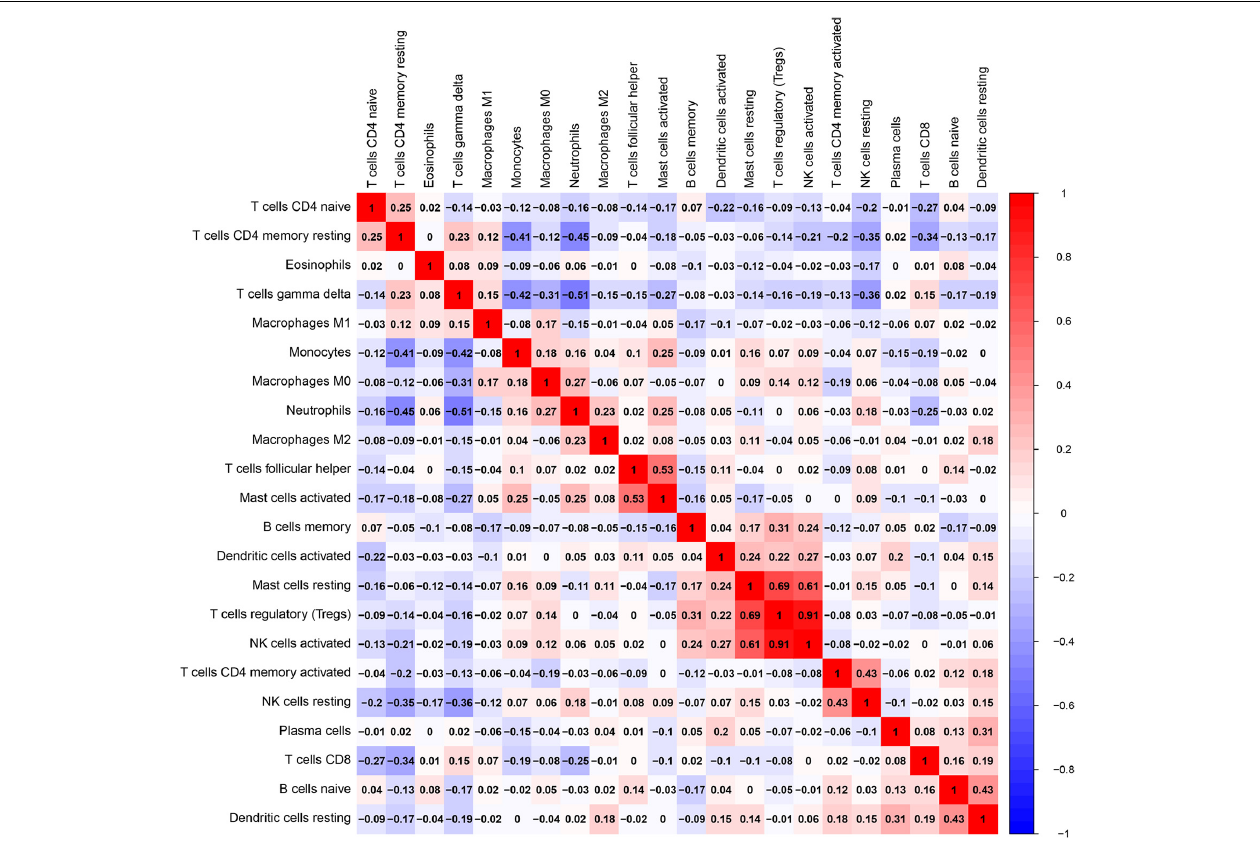
FIGURE 11 | Correlation matrix among fractions of 22 immune cell subtype. Red: positive correlation; white: the same correlation levels; and blue: negative